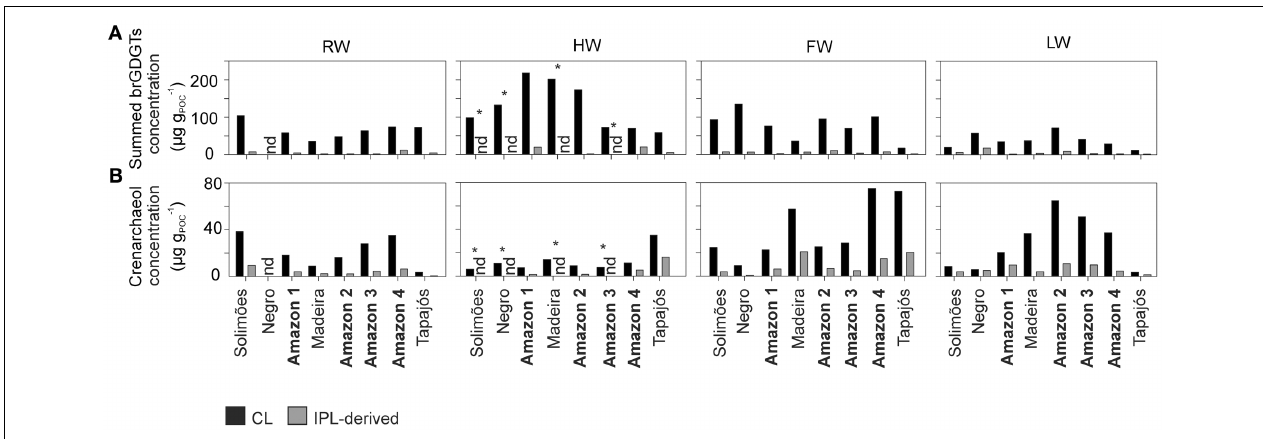
FIGURE 5 | Concentration of CL and IPL-derived summed brGDGTs (A) and crenarchaeol (B) normalized to POC along the Amazon main stem and its tributaries in the four different seasons (nd, no data; ∗ only the CL fraction was analyzed).